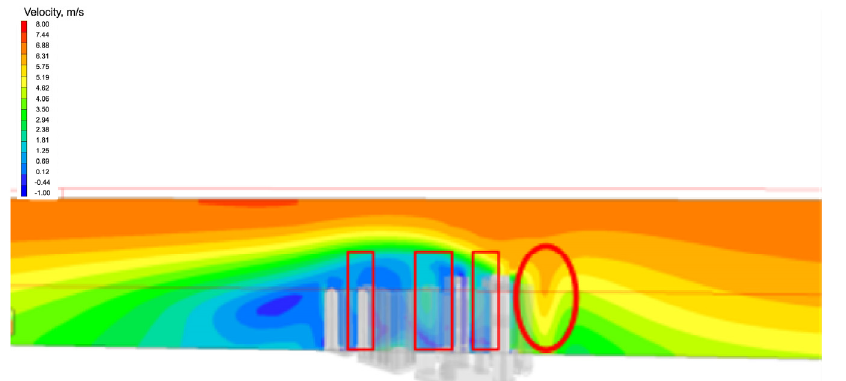
Figure A5. Winter vector diagram, winter wind field pressure vector diagram, and winter vector diagram of wind field flow velocity at 10 m height.